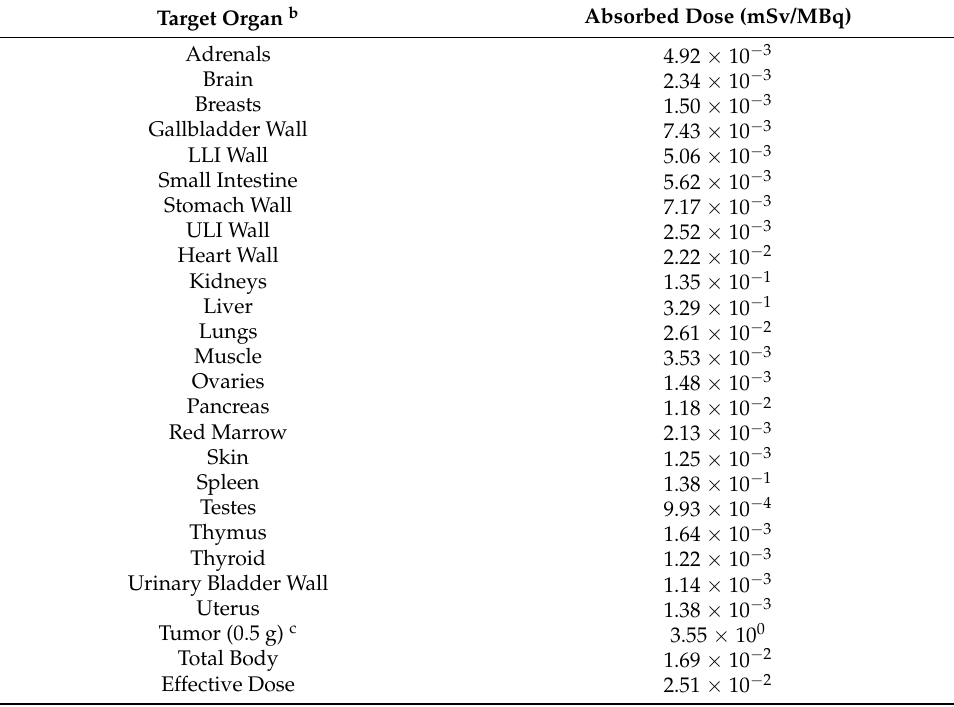
Table 2. Radiation dose estimates for intratumoral injection of 177 Lu-DTPA-pAuNS in an adult human a .